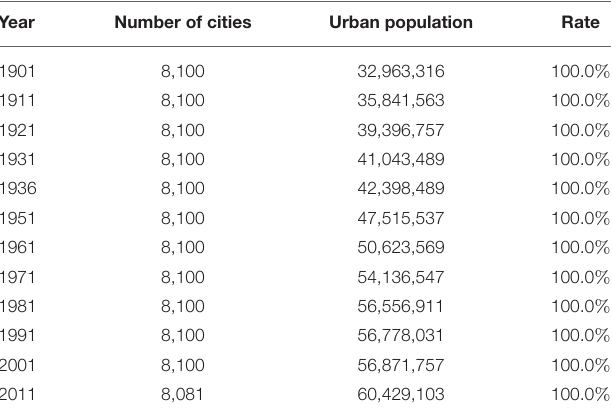
TABLE 2 | Summary of population data for Italy.